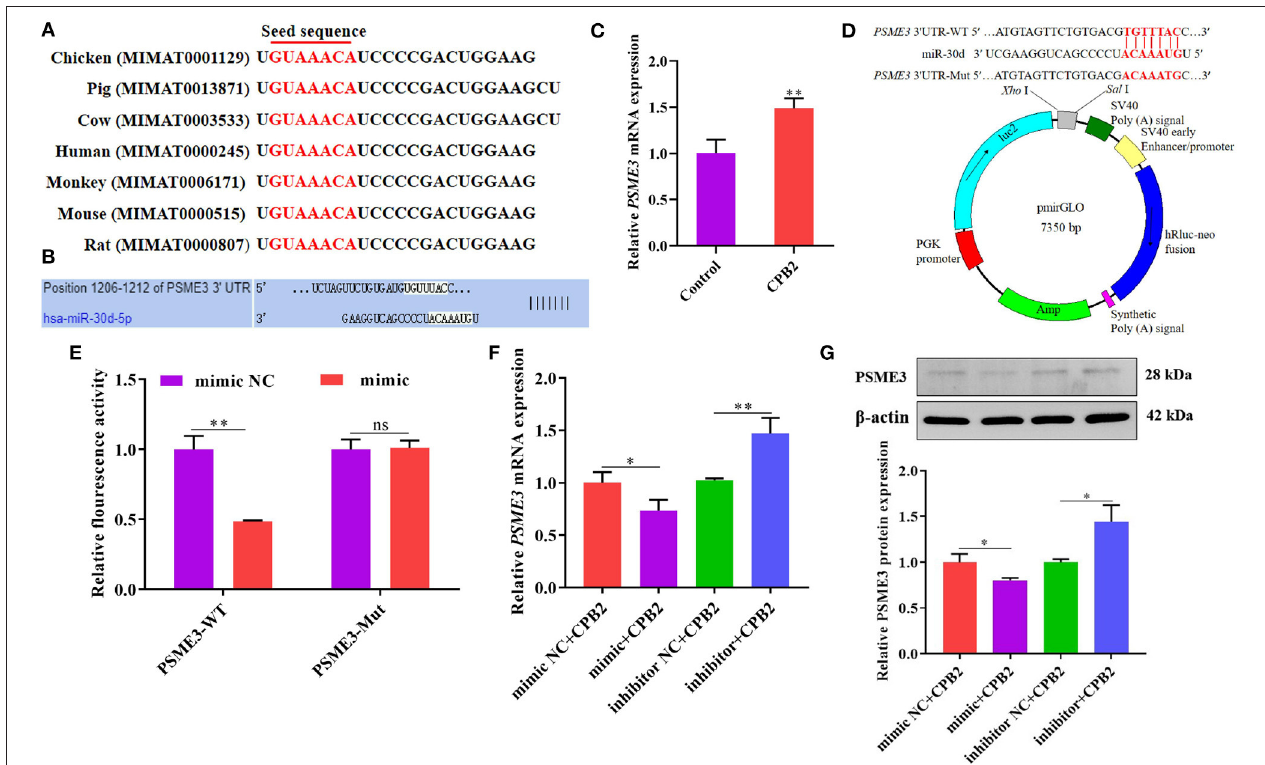
FIGURE 4 | miR-30d negatively regulated the expression of PSME3 . (A) The matured sequence of miR-30d was aligned in chicken, pig, cow, human, monkey, mouse, and rat. (B) TargetScan analyzed the binding site of miR-30d to PSME3. (C) qPCR analysis of PSME3 expression in CPB2 toxin revulsive IPEC-J2 cells. (D) Comparison of the PSME3 3’UTR-WT and Mut vectors. (E) The relative luciferase activity of the IPEC-J2 cells after co-transfected with miR-30d mimic or mimic NC and PSME3 3’UTR-WT or Mut. (F,G) The miR-30d mimic and the inhibitor were transfected into IPEC-J2 for 36h, (F) the mRNA level of PSME3 was evaluated through qPCR, (G) the protein level of PSME3 was evaluated via western blot. ns: not significant, * p < 0.05, ** p <